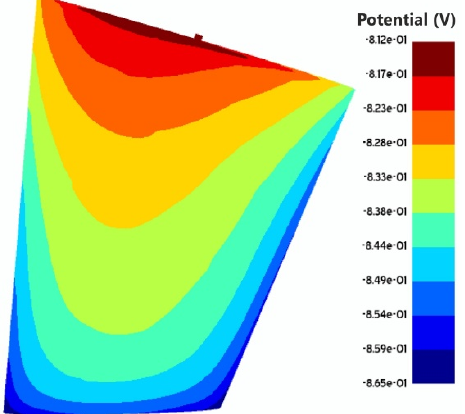
Figure 11. Potential distribution φ (V vs Ag/AgCl/seawater) at the steel rudder.